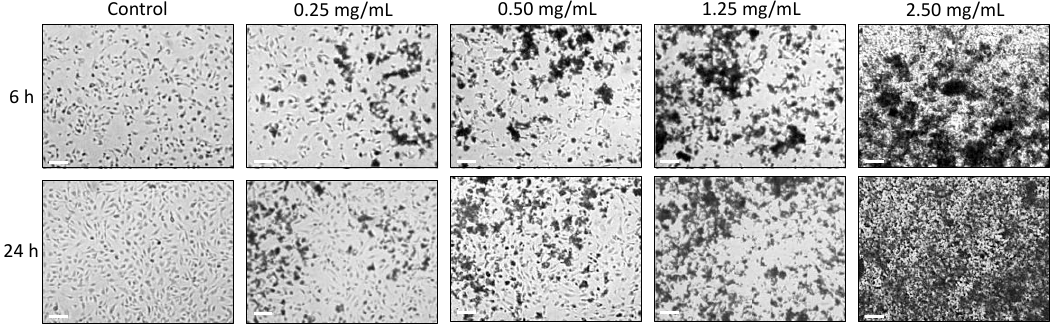
Figure 9. Microscopical images of the effect of nPSi-βCD microparticles exposition to HUVECs during a 6 and 24 h culture. Images were taken at 8X magnification. Scale bars: 1 mm.